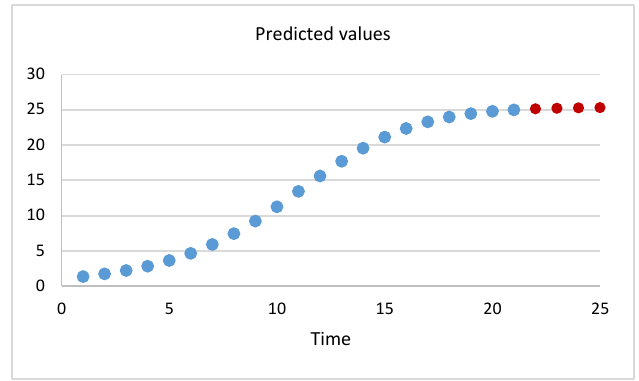
Table 7. Predicted values by proposed model for dataset 2.